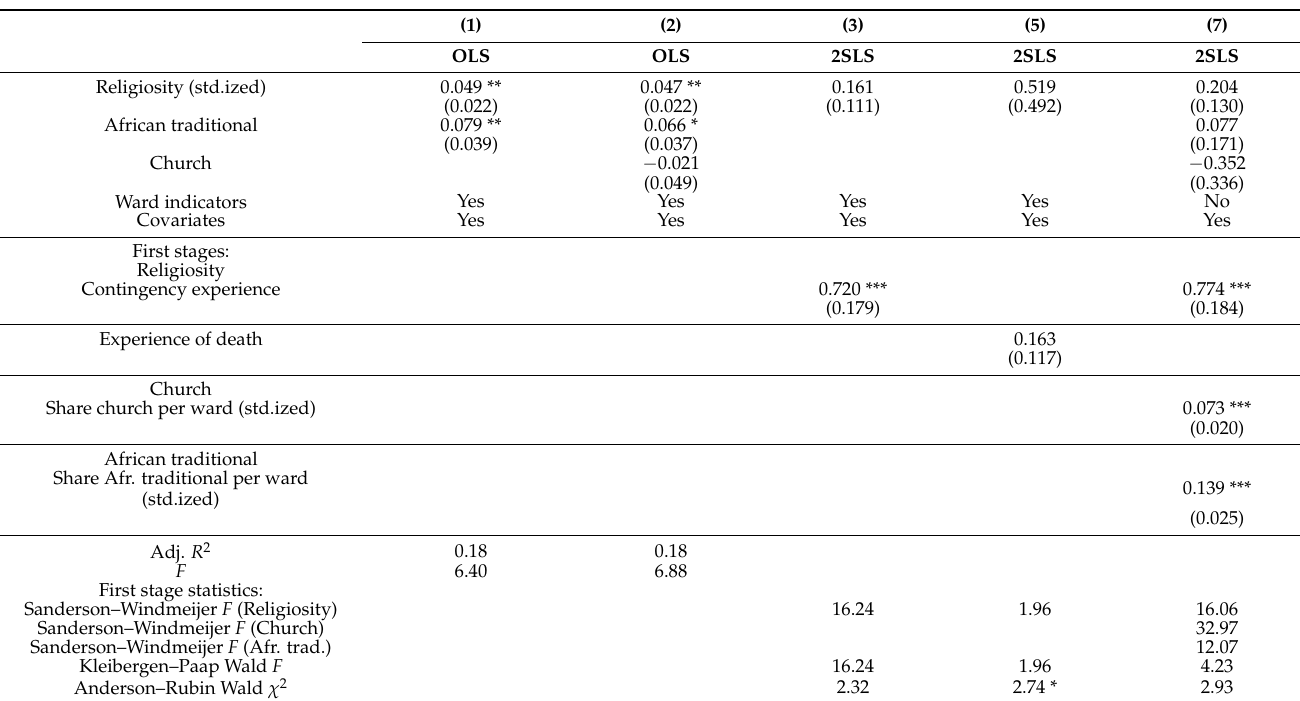
Table A5. Estimation results linear probability model—subsample of persons not (self-)employed in the formal sector.